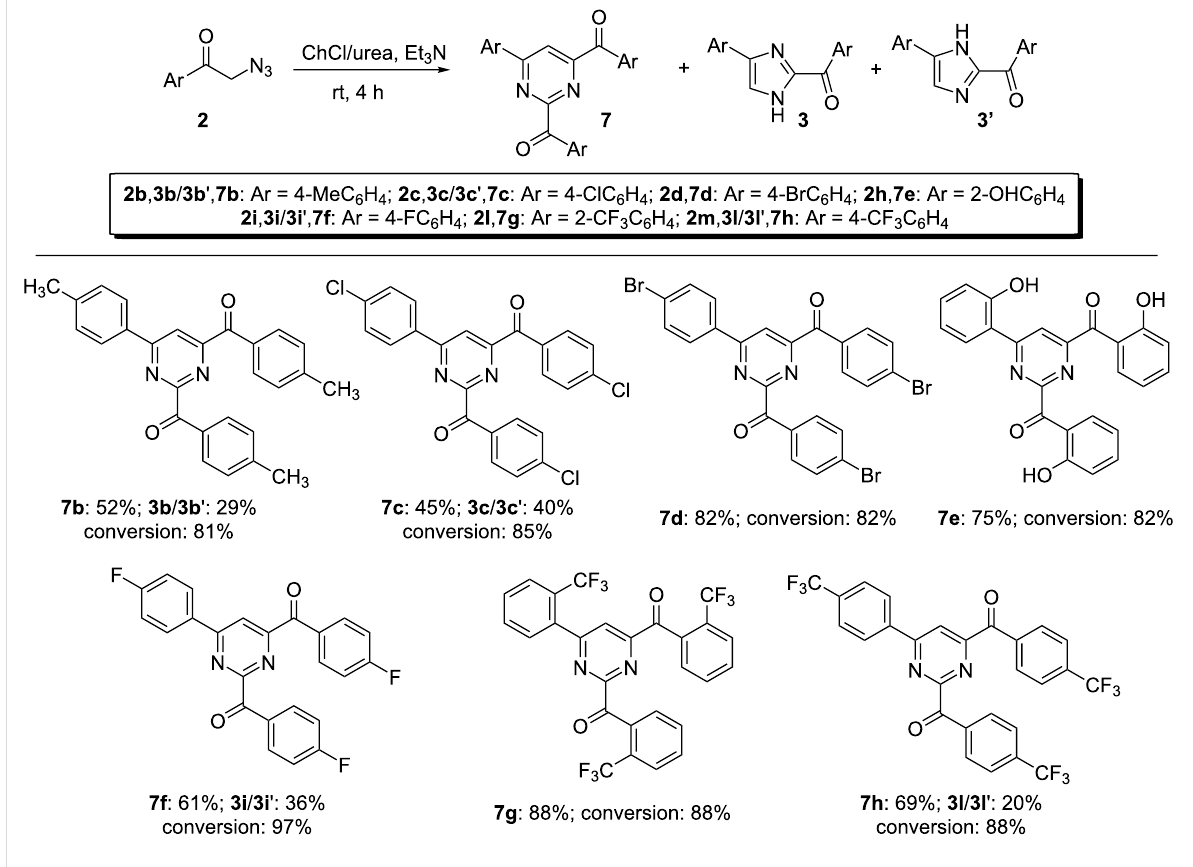
Scheme 6: Scope of the synthesis of 2,4-diaroyl-6-arylpyrimidines 7 . Typical conditions: 2 (0.3 mmol), Et 3 N (0.9 mmol), ChCl/urea (0.5 g), rt, 4 h; yield refers to products isolated after column chromatography on silica gel; synthesis of pyrimidine derivatives 7b and 7d , reaction time: 12